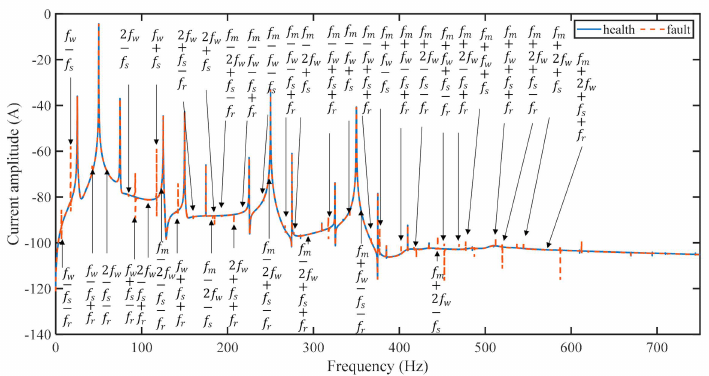
Figure 13. Simulated stator current spectra for the chipping defect at the sun gear.